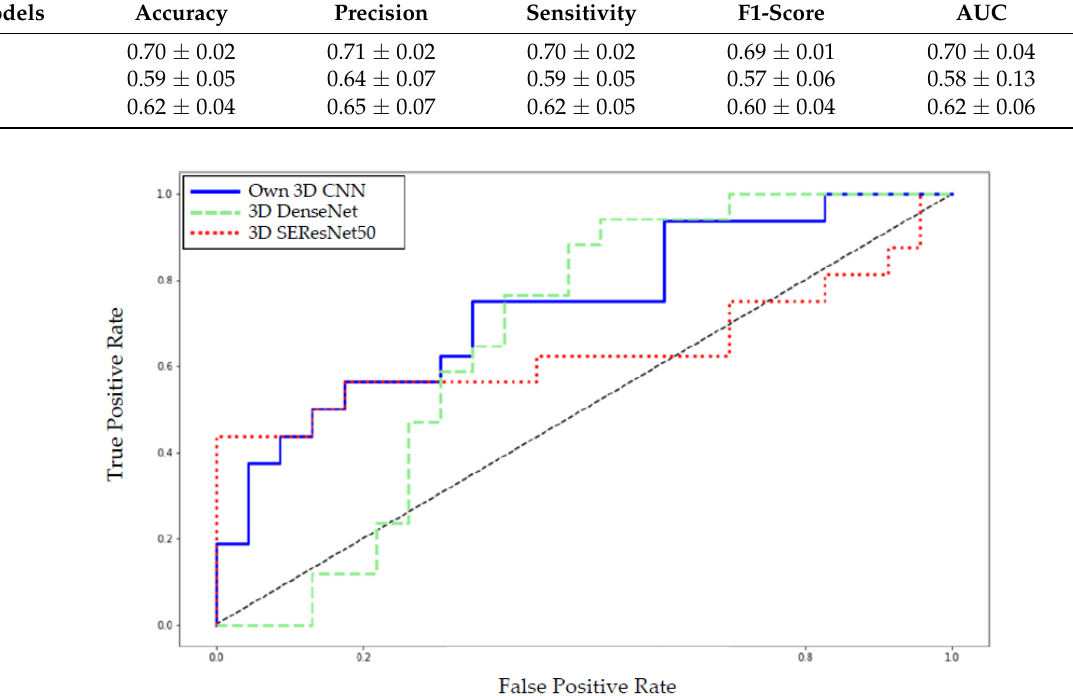
Figure 7. The deep learning models’ receiver operating characteristics (ROC) curve shows our 3D network mostly outperforming the 3D DenseNet and 3D SEResNet50.